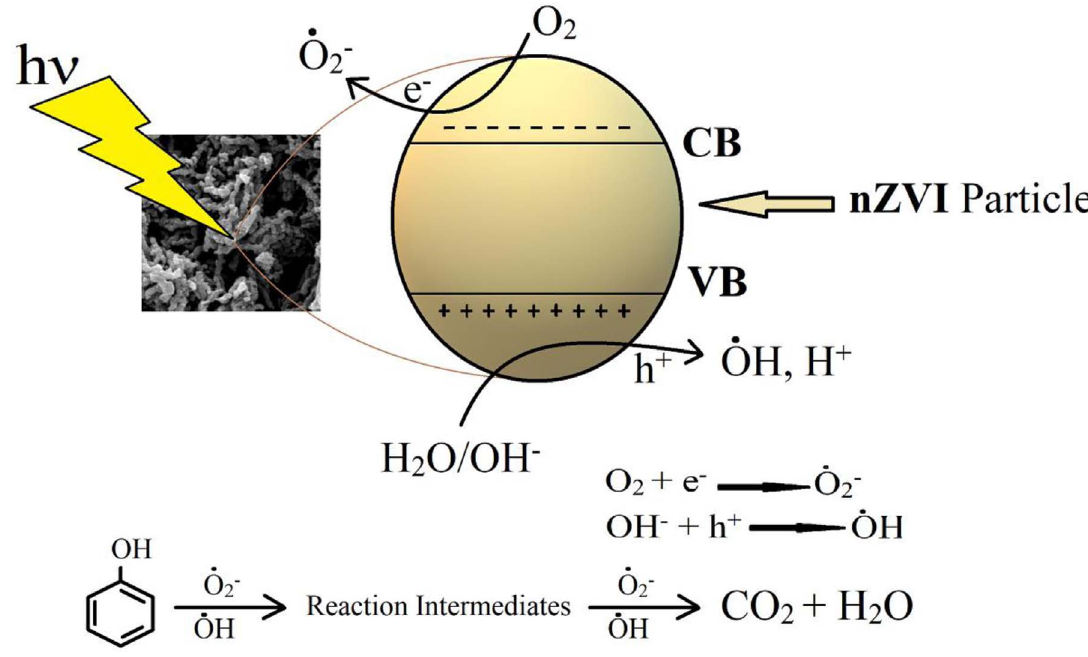
Figure 4. Mechanism of Phenol degradation using nZVI particle in presence of light.